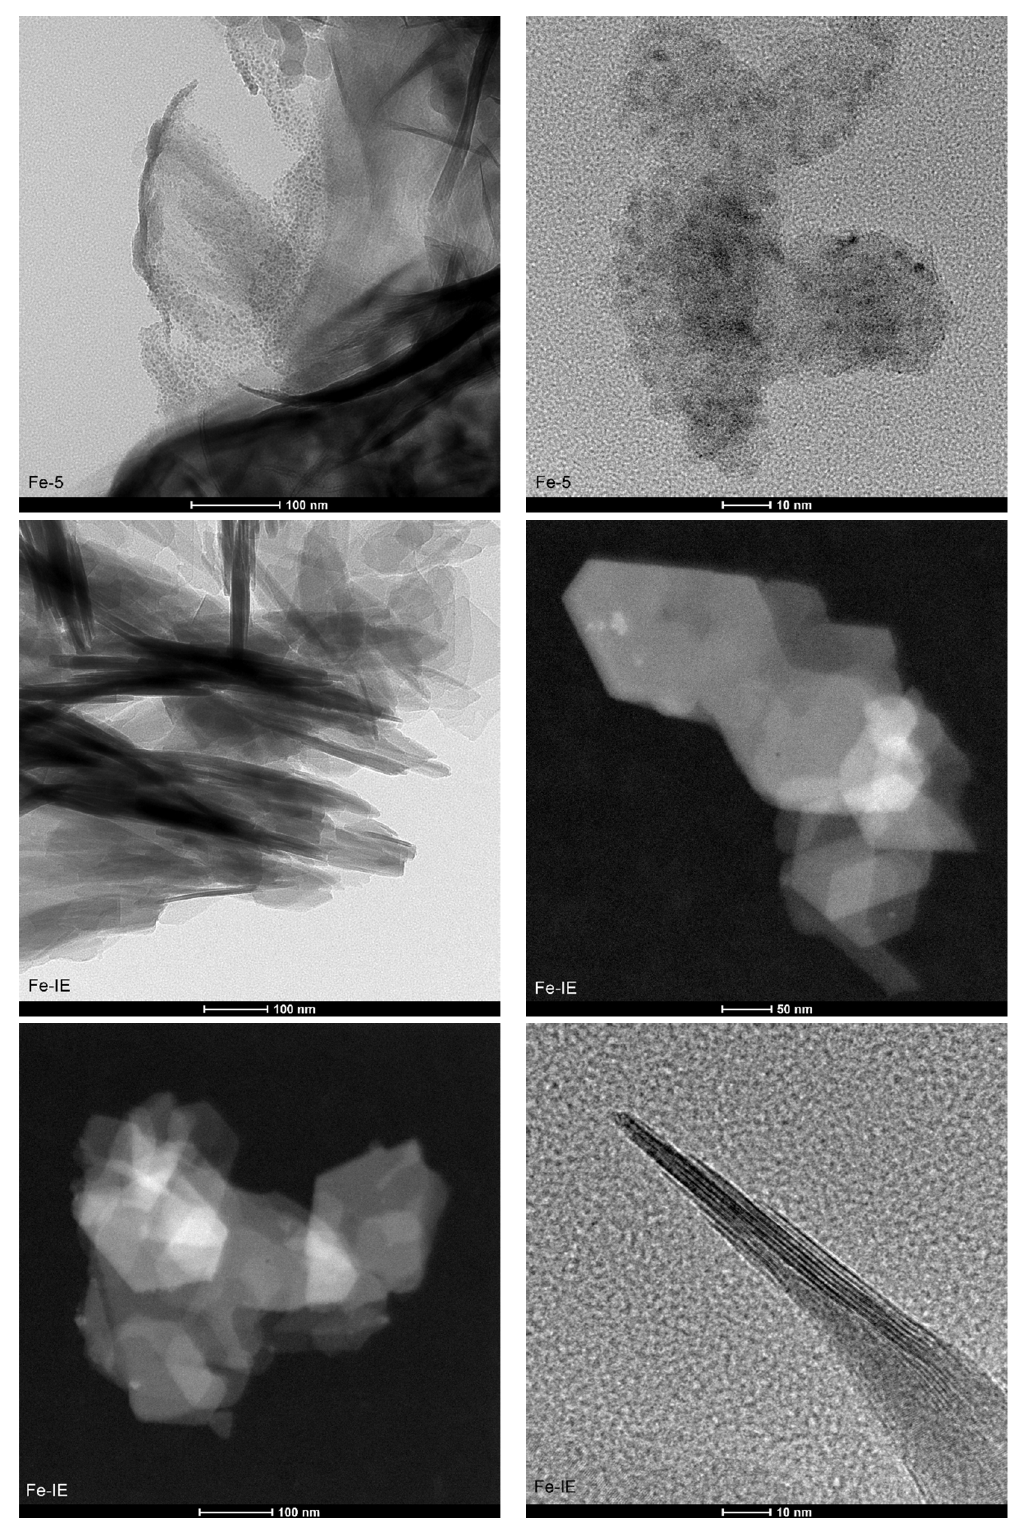
Figure 7. TEM images of the samples recorded in various modes.